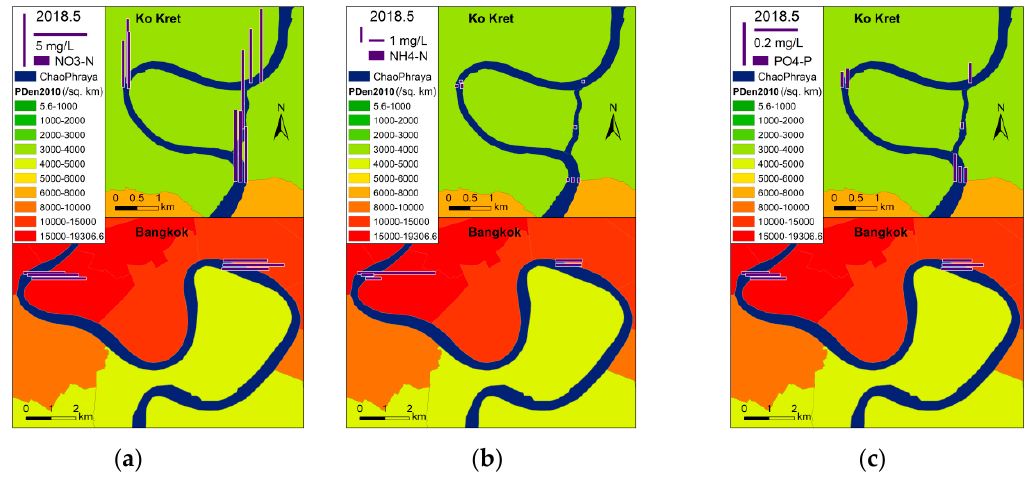
Figure 13. Nutrients concentrations along the two river bends. ( a ) NO 3 -N; ( b ) NH 4 -N; ( c ) PO 4 -P.